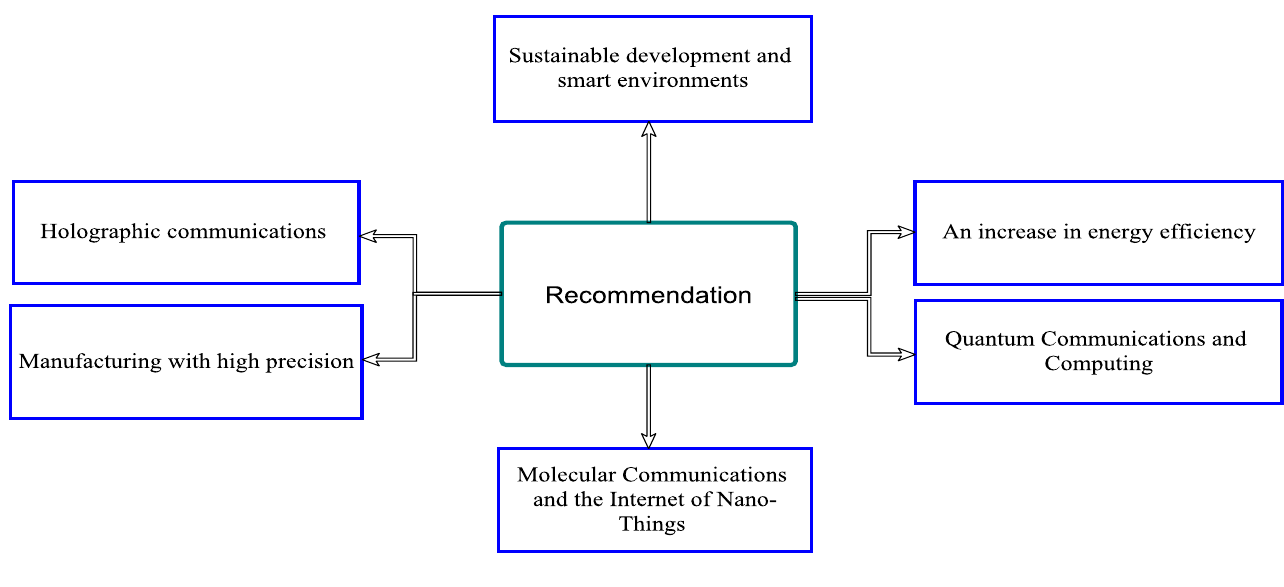
Figure 7. Categories of